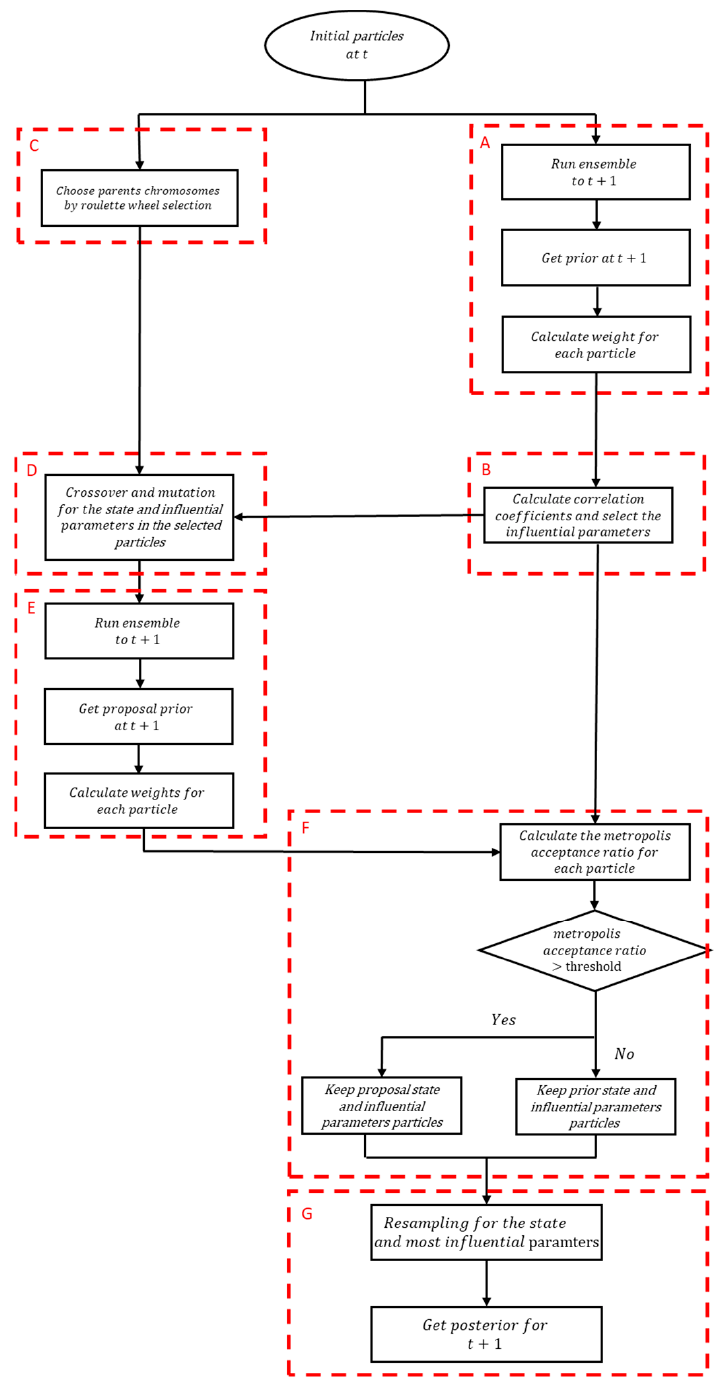
Figure 1. The overall framework including stages